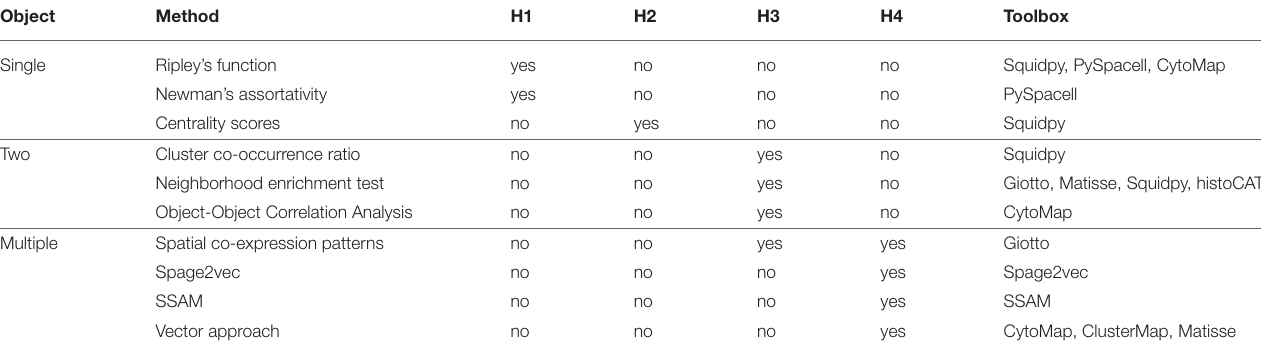
TABLE 1 | Overview of the methods’ functionality.